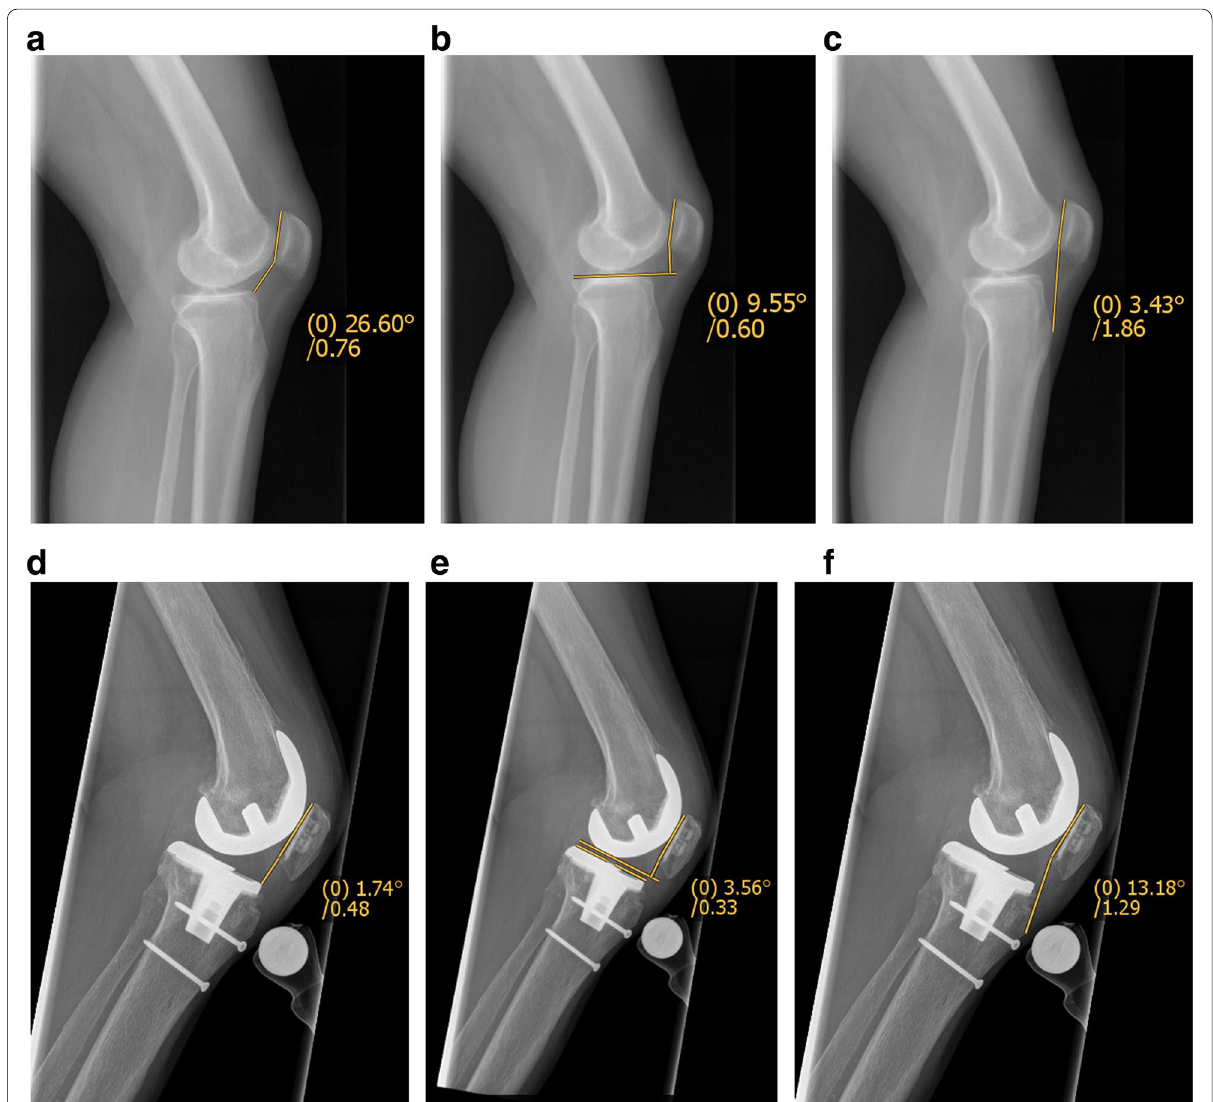
Fig. 2 a Measurement of the Caton-Deschamps index (CDI) in the left native knee joint of a 63-year-old woman. b Measurement of the Blackburne-Peel ratio (BP) in the left native knee joint of a 63-year-old woman. c Measurement of the modified Insall-Salvati index (MIS) in the left native knee joint of a 63-year-old woman. d Measurement of the Caton-Deschamps index (CDI) in the left knee joint of a 63-year-old woman with TKA. e Measurement of the Blackburne-Peel ratio (BP) in the left knee joint of a 63-year-old woman with TKA. f Measurement of the modified Insall-Salvati index (MIS) in the left knee joint of a 63-year-old woman with TKA